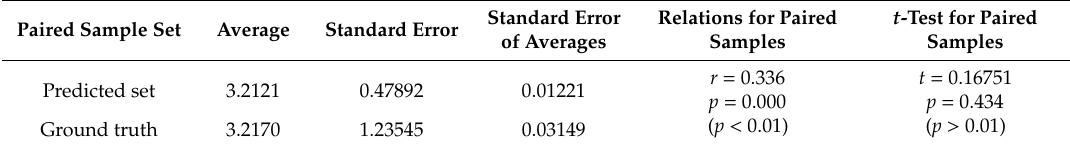
Table 4. Experimental results of objective evaluations.